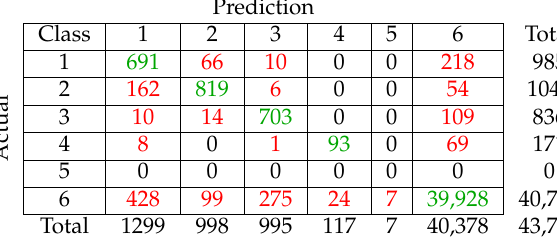
Table 7. Confusion matrix displaying results from the CNN classifier. The green highlighted numbers are true positives, and the red highlighted numbers are false positives.